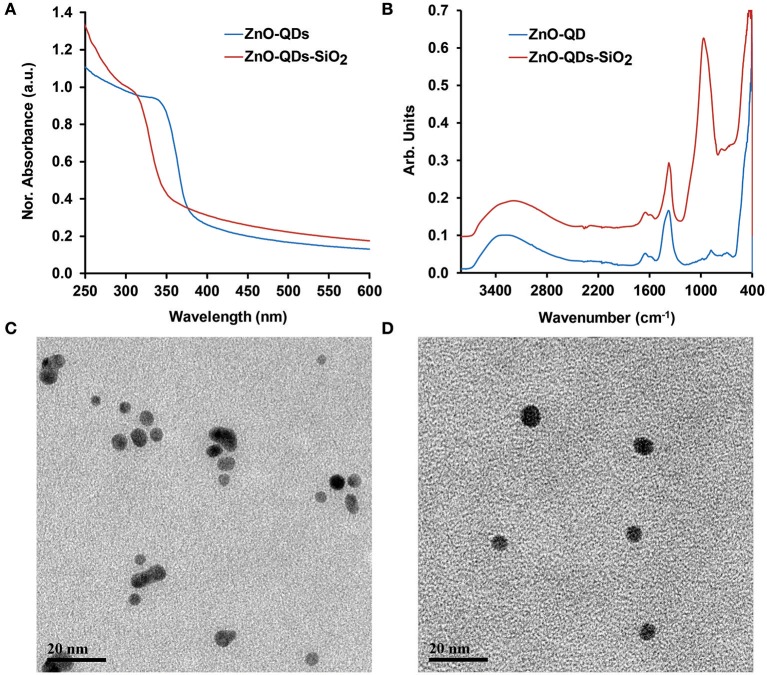
(A) UV-VIS and (B) ATR-FTIR spectra obtained before and after TEOS modification of ZnO-QDs; TEM images of (C) ZnO-QDs; and (D) ZnO-QDs-SiO2.